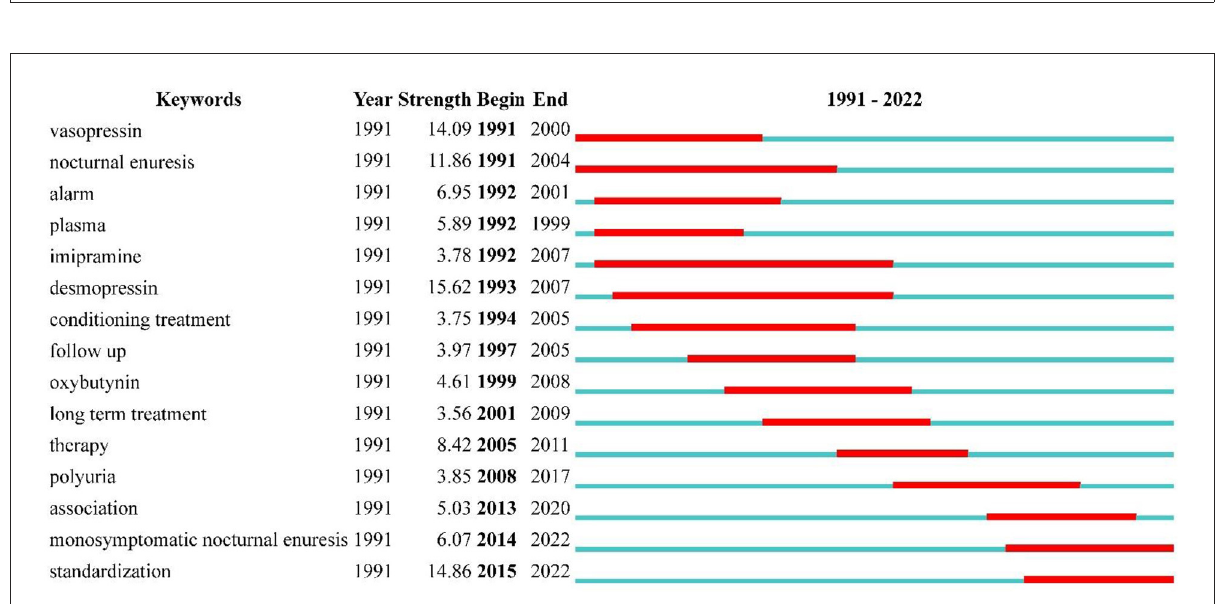
FIGURE8 Top 15 Keywords with the Strongest Citation Bursts. The keyword marked in red indicates a sudden increase in the frequency of the keyword during this period. Keywords marked in blue indicate a period of relative